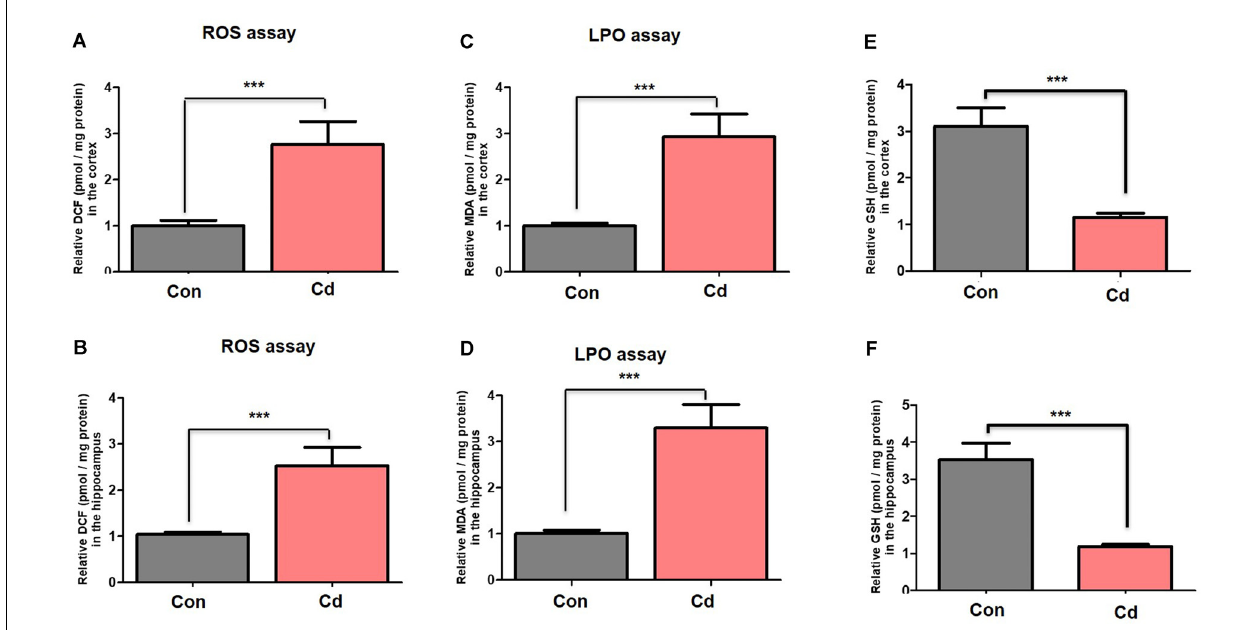
FIGURE 4 | Chronic Cd exposure escalated oxidative stress/ROS accumulation. (A,B) Histograms indicated results of ROS assay in the cortical and hippocampal regions of the mouse brain. The results were represented as the means ± SEM (number = 7 mice/group) for three repeated independent and reproducible experiments. Significance = *** p < 0.001; Student’s unpaired t -test. (C,D) Histograms indicated results of LPO assay and MDA analyses in the cortical and hippocampal regions of the mouse brain. The results were represented as the means ± SEM (number = 7 mice/group) for three repeated independent